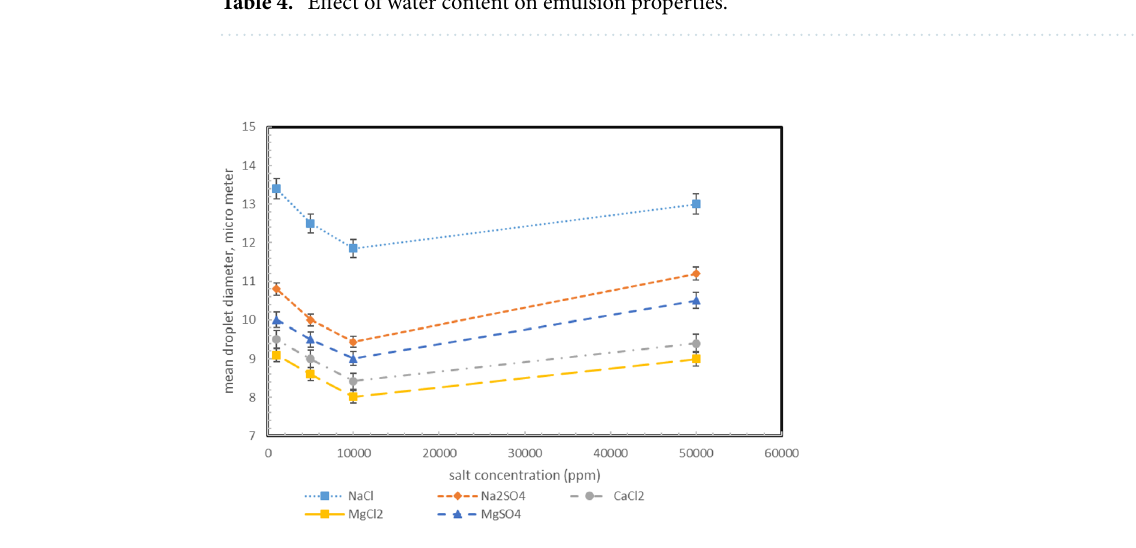
Figure 6. Effect of salt type on mean droplet size at 50% water content.